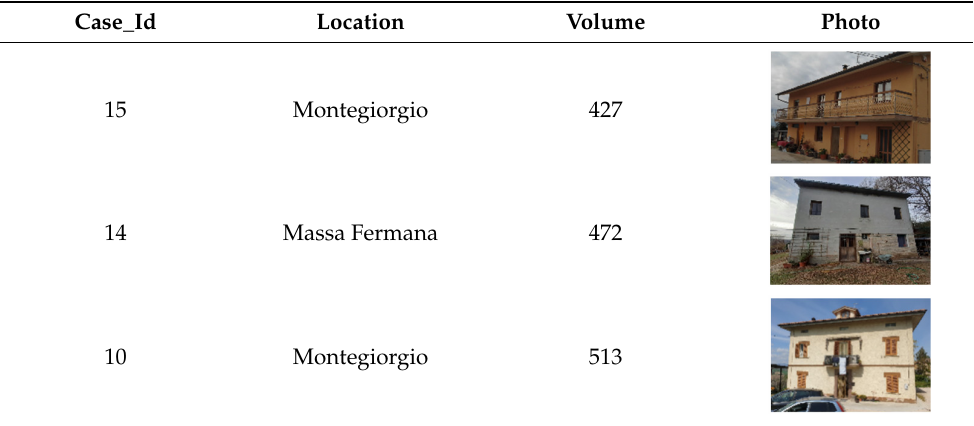
Table 4. The result of the case base